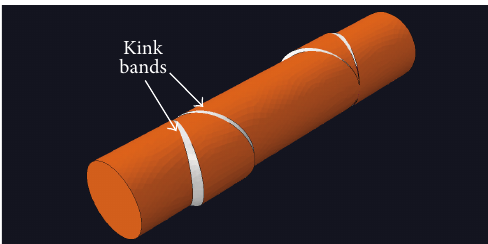
Figure 4: A schematic of a series of kink bands formed over a short segment of a PPTA